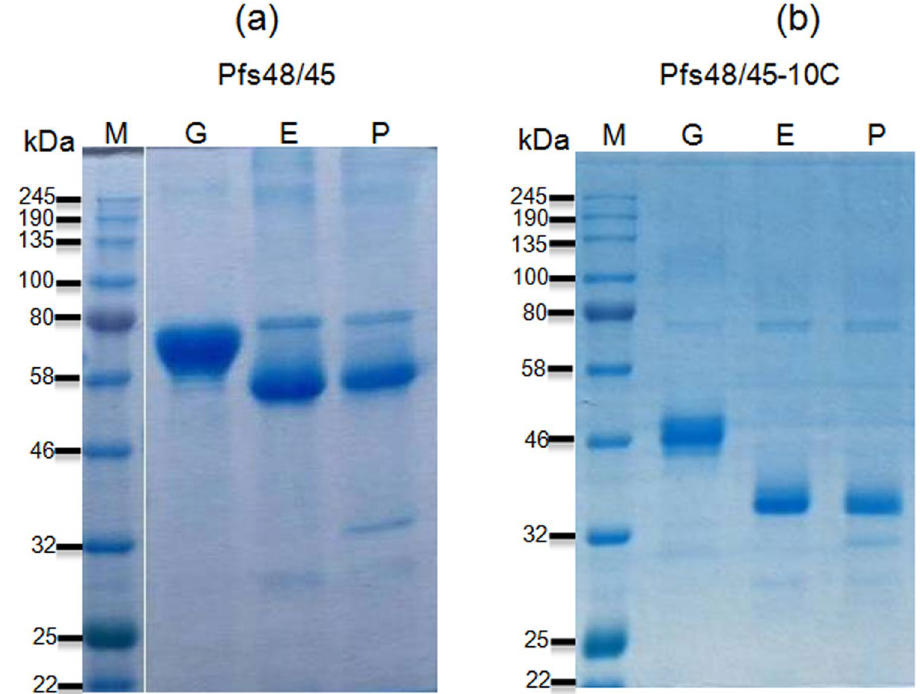
Figure 2. SDS-PAGE analysis of purified, plant produced Pfs48/45 and Pfs48/45-10C variants. ( a ) SDS-PAGE analysis of purified, plant produced full length Pfs48/45 variants; ( b ) SDS-PAGE analysis of purified, plant produced Pfs48/45-10C variants. Lanes were loaded with ~3.0 μ g per lane for glycosylated (G), Endo H (E) or PNGase F (P) in vivo deglycosylated plant produced Pfs48/45 or Pfs48/45-10C proteins. M: color prestained protein